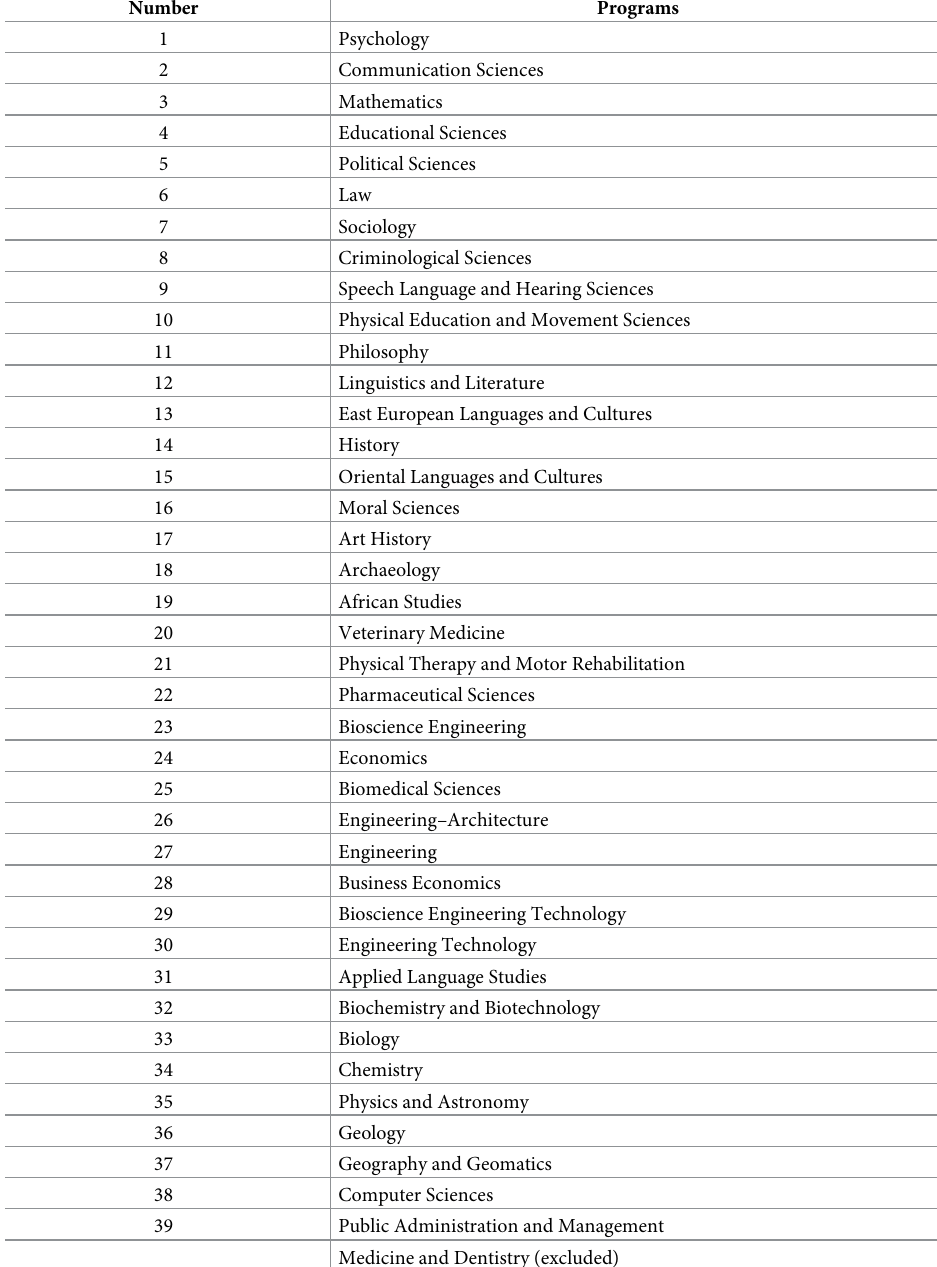
Table 1. Study programs included in the present